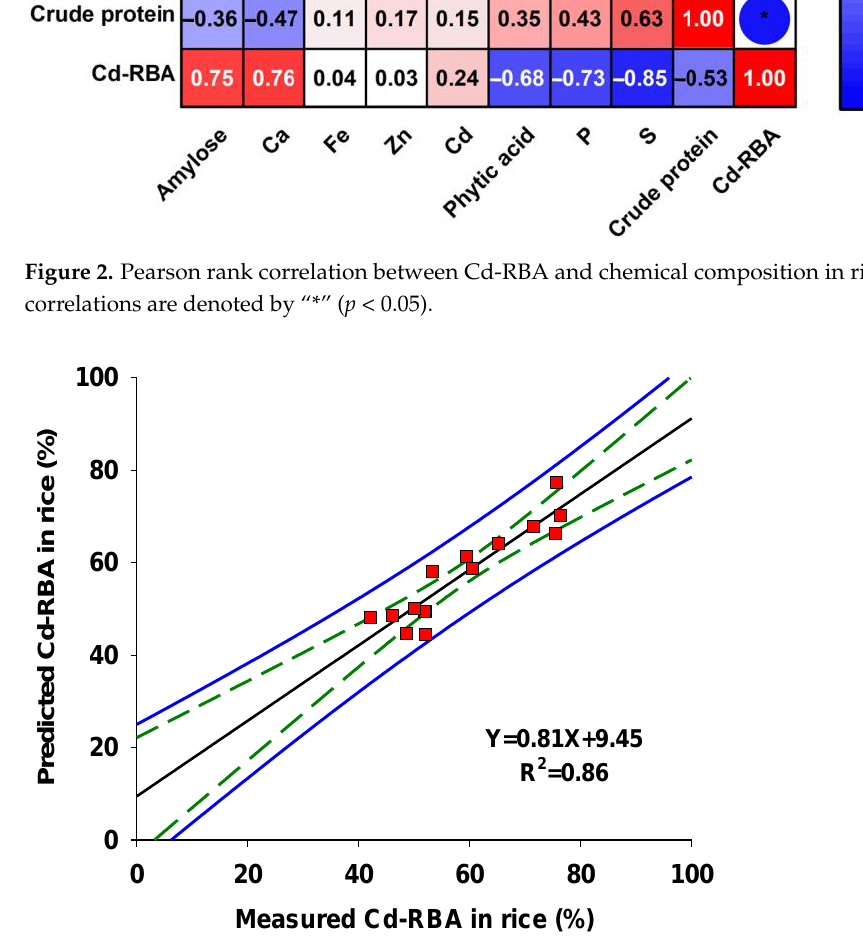
Figure 3. Correlations between measured and predicted Cd-RBA based on Ca and phytic acid concentrations in rice. Blue solid lines and green dashed lines represent 95% prediction and confidence bands, respectively.